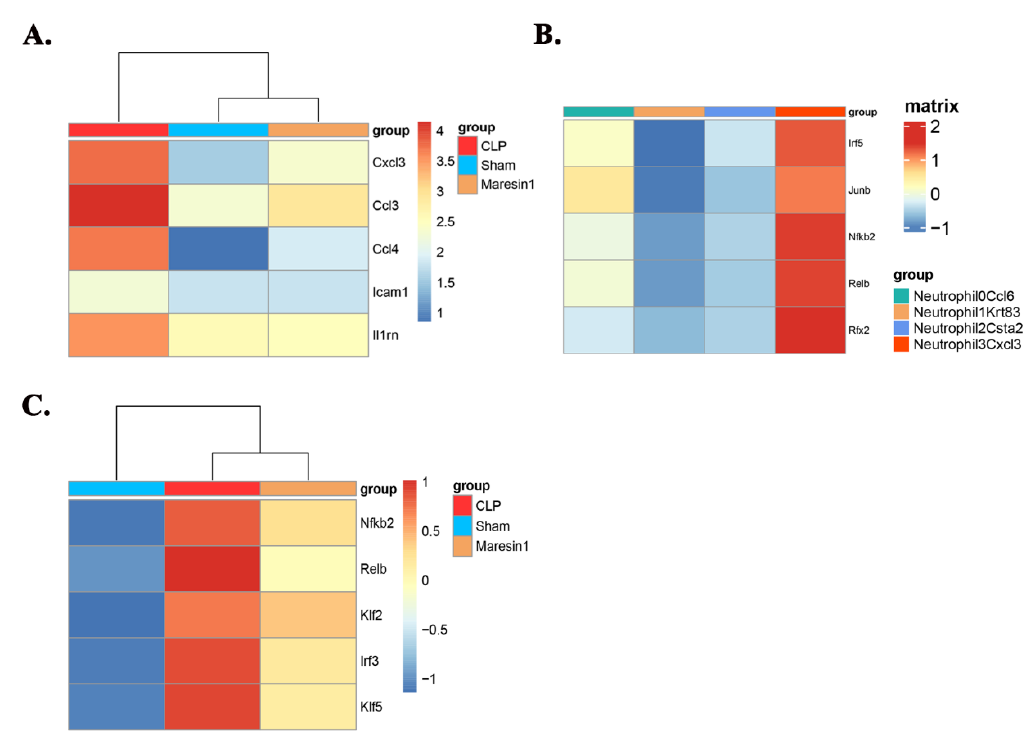
Figure 4. Maresin1 regulates gene expression and transcription factor expression of the neutrophil- Cxcl3 subset. ( A ): The heat map of the average expression levels of related genes for different groups. ( B ): The heat map of the regulon activity scores of TF motifs estimated per cell by pSCENIC. Shown are five differential activated motifs in the Neutrophil-cxcl3 subpopulation. ( C ): Maresin1 suppresses the expression levels of key transcription factors of the Neutrophil-cxcl3 subpopulation.